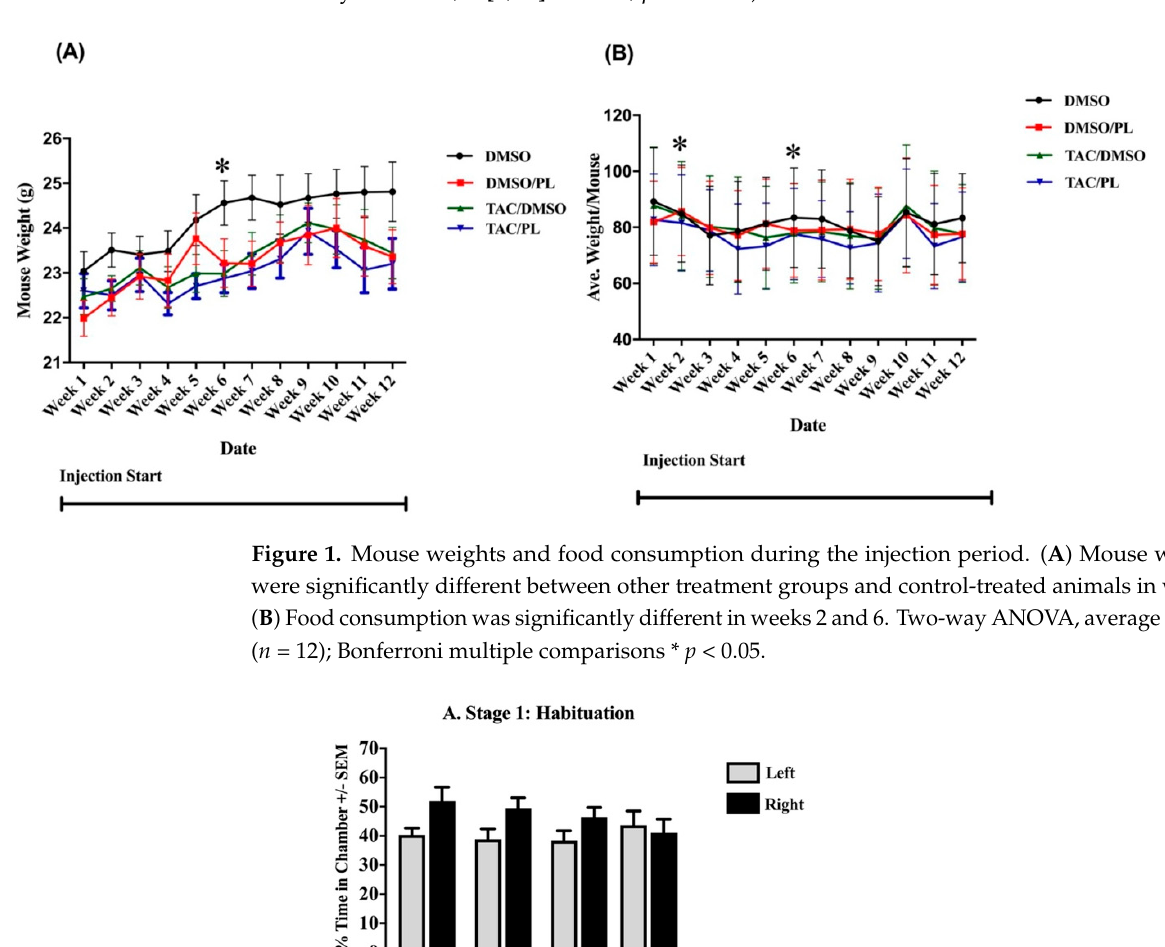
Figure 1. Mouse weights and food consumption during the injection period. ( A ) Mouse weights were significantly different between other treatment groups and control-treated animals in week 6. ( B ) Food consumption was significantly different in weeks 2 and 6. Two-way ANOVA, average ± SEM ( n = 12); Bonferroni multiple comparisons * p < 0.05.